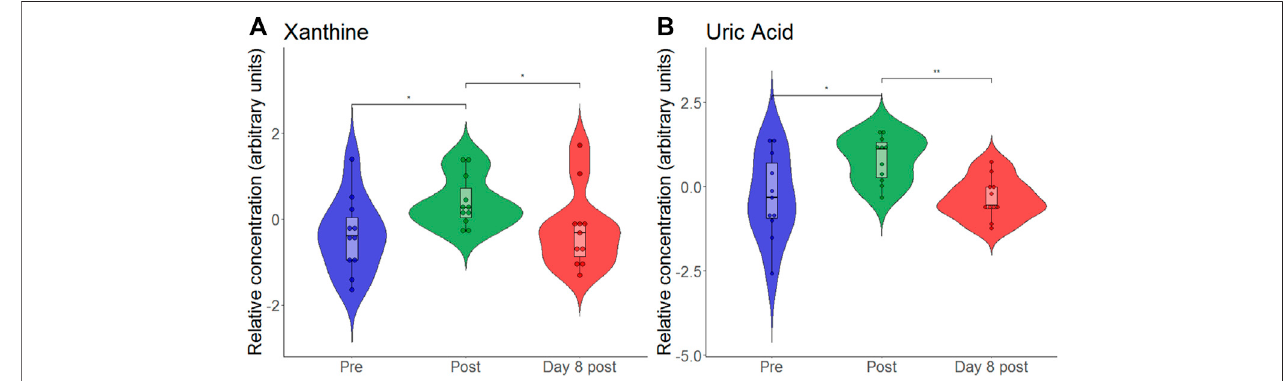
FIGURE 7 | Violon plots showing relative blood metabolite concentrations at baseline before (pre), immediately after (post) and on day 8 after (day 8 post) the eccentric exercise for xanthine (A) and uric acid (B) . * p ≤ 0.05, ** p ≤ 0.01.